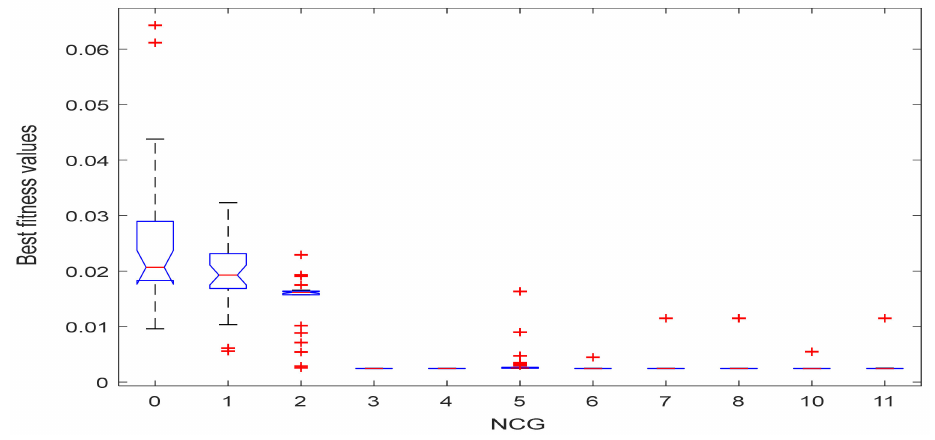
Figure 3. Sensitivity analysis of parameter NCG.